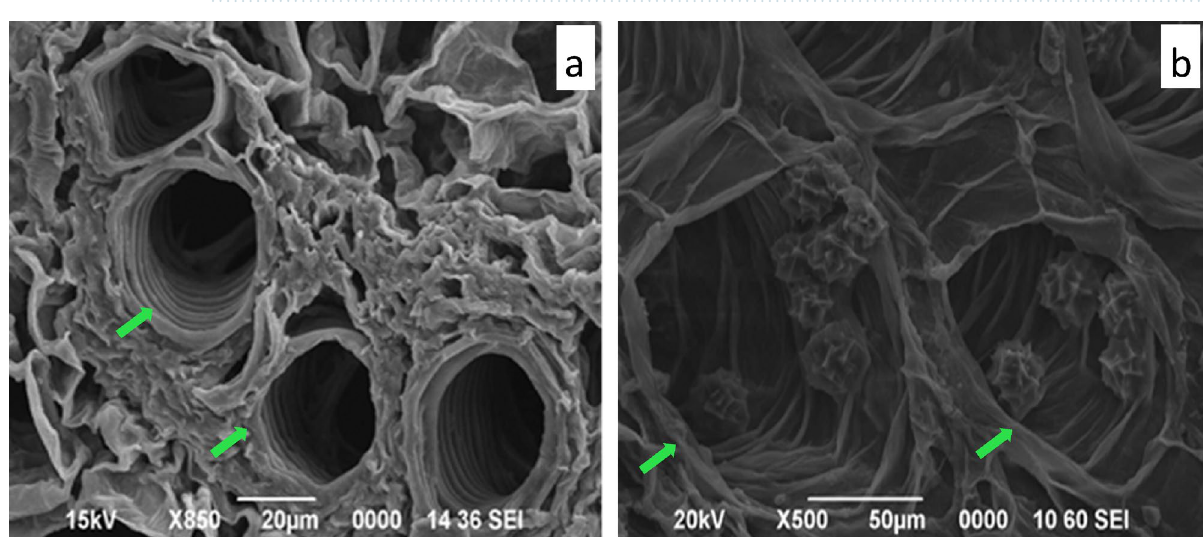
Figure 3. SEM micrographs of abaxial side of T. natans leaf: ( a ) leaf epidermis showing stomata in control leaf ( b ) leaf epidermis showing stomata in Sb treated leaf.